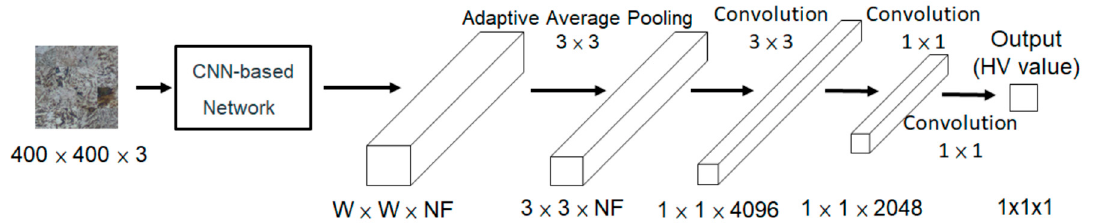
Figure 6. A fully convolutional neural network model architecture for HV. Here, NF refers to the number of filters of the underline CNN backbone.